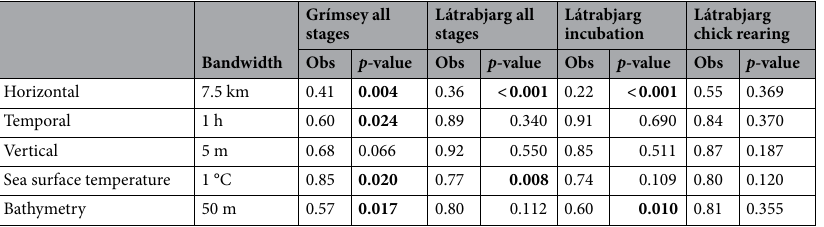
Table 1. Overlap between common and Brünnich’s guillemots along different axes. “Obs.” = observed segregation value; “ p -value” = proportion of simulated overlap values (from species labels permutations) that are lower than the observed. p-values below 0.05 are highlighted in